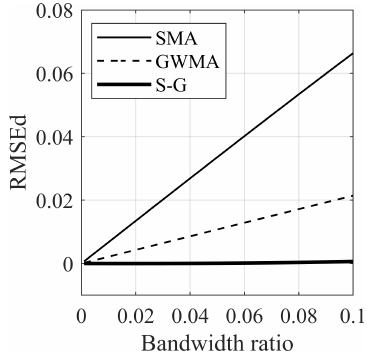
Figure 10. RMSEd for the harmonic